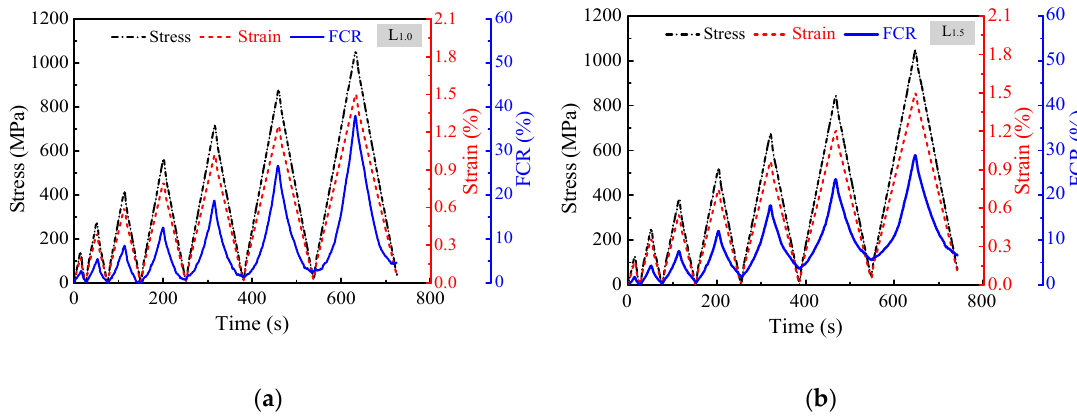
Figure 12. Typical in situ monitoring of ( a ) L 1.0 and ( b ) L 1.5 under incremental amplitude cyclic tensile loading.